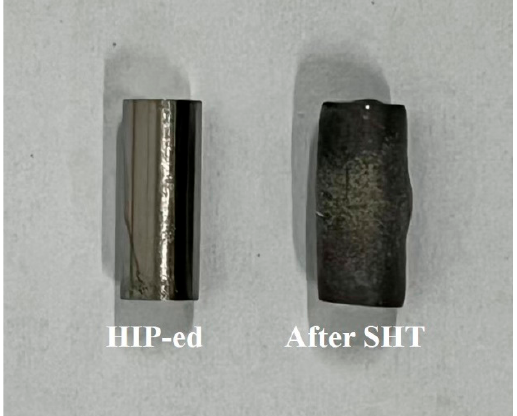
Figure 8. The shape of the Ni1# specimen before and after 1200 °C × 8 h solution heat treatment.